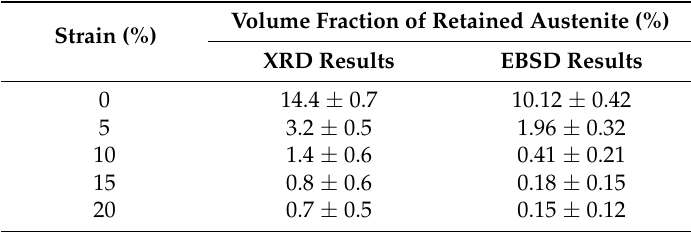
Table 1. Volume fractions of retained austenite at different strain levels measured by XRD and EBSD.